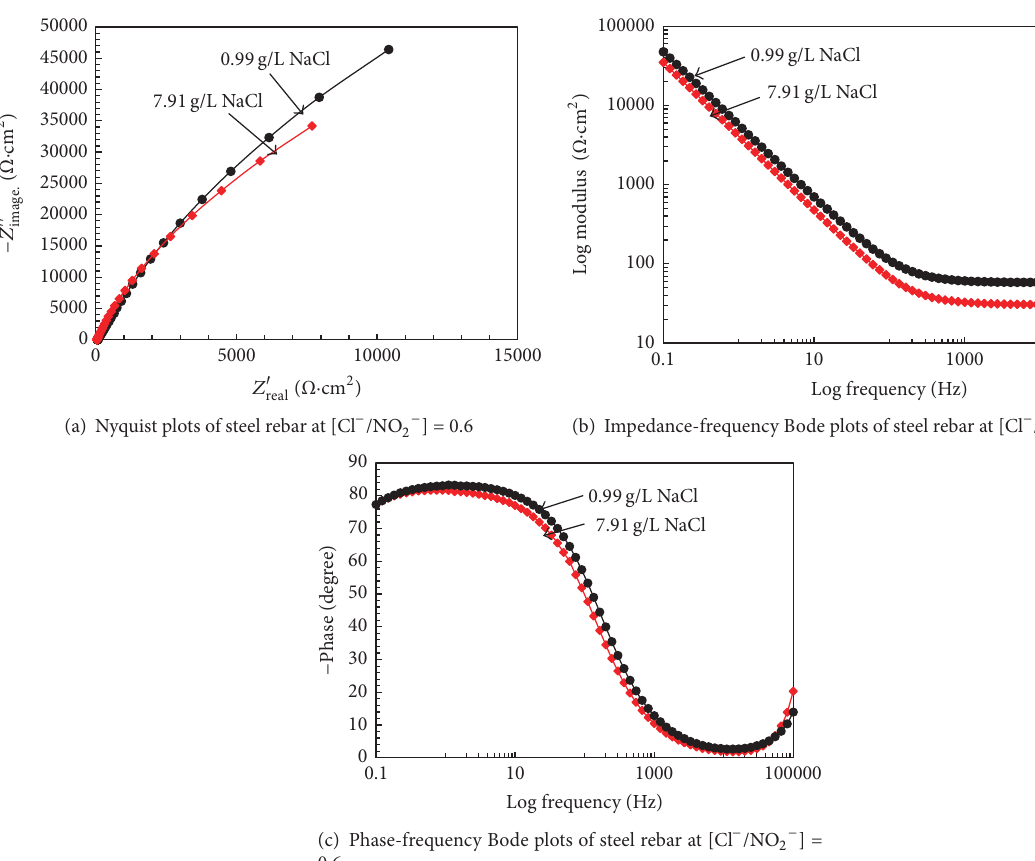
Figure 5: Electrochemical plots of steel rebar exposed in saturated Ca(OH) 2 solution with different concentrations of NaCl at [Cl − /NO 2− ] =